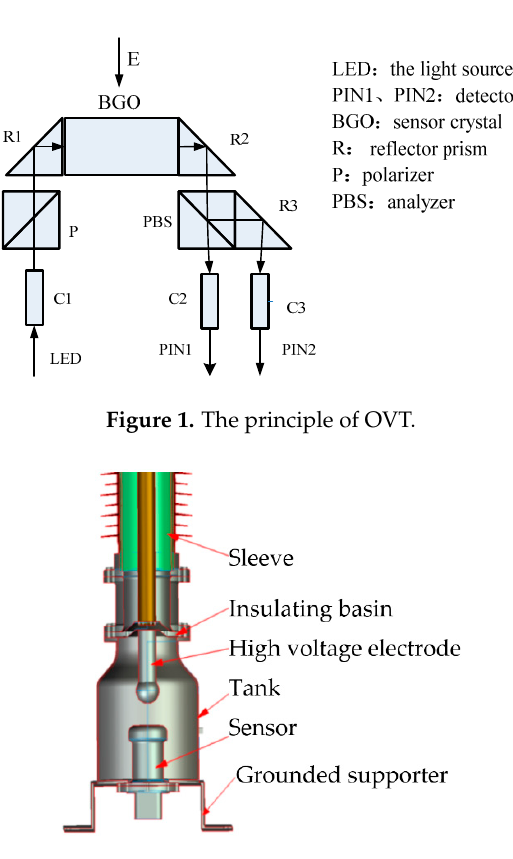
Figure 2. The installation structure diagram of OVT.